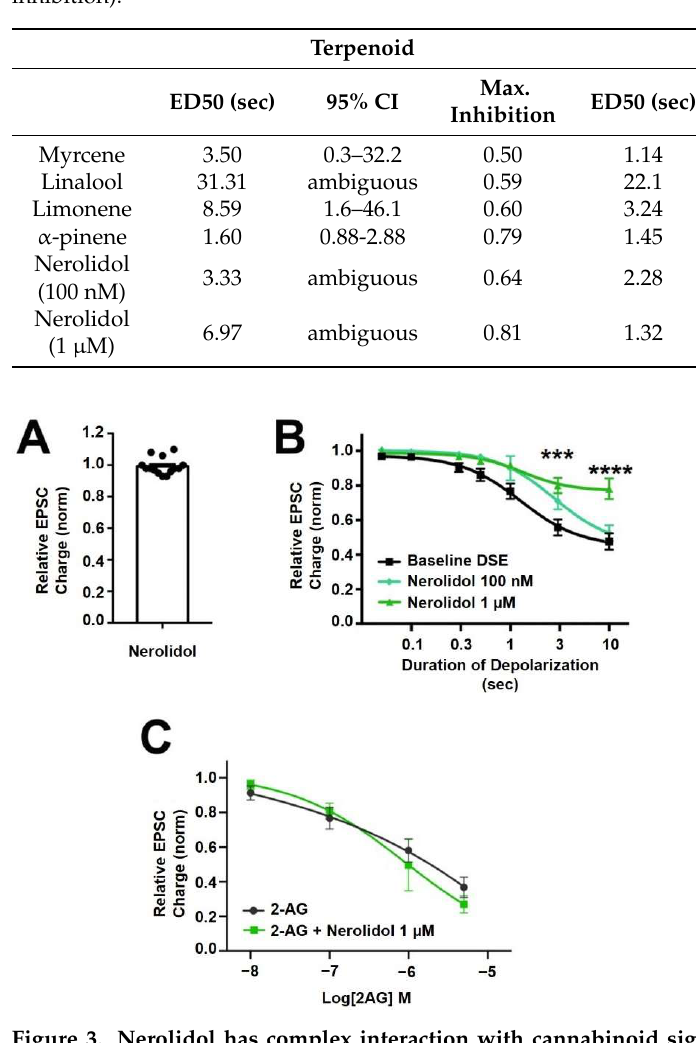
Figure 4. Nerolidol does not alter the basal activity of DAGLα. ( A ) Sample Enzchek lipase activity time course in the presence of vehicle (black) or nerolidol (3 µM, red) in DAGLα-transfected CHO cells. ( B ) Summarized results show lipase activity in DAGLα-expressing CHO cells in response to vehicle or nerolidol ( n = 3).